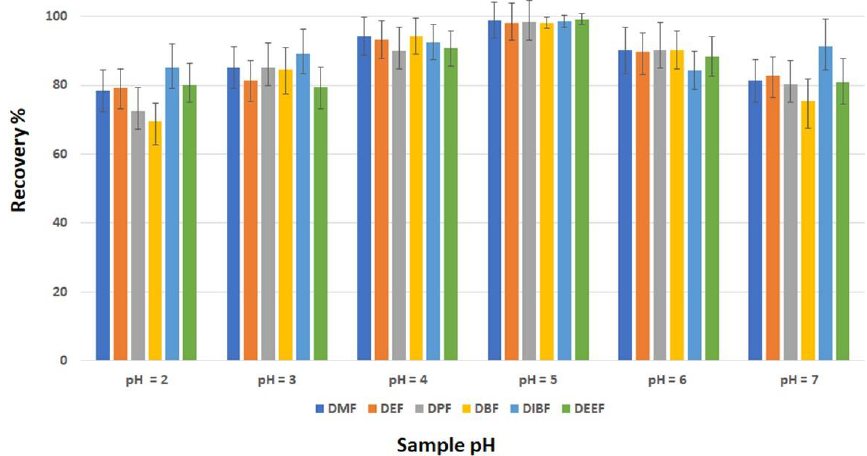
Figure 2. Effect of sample pH on the extraction of phthalates for the SPE-HPLC-PDA method.